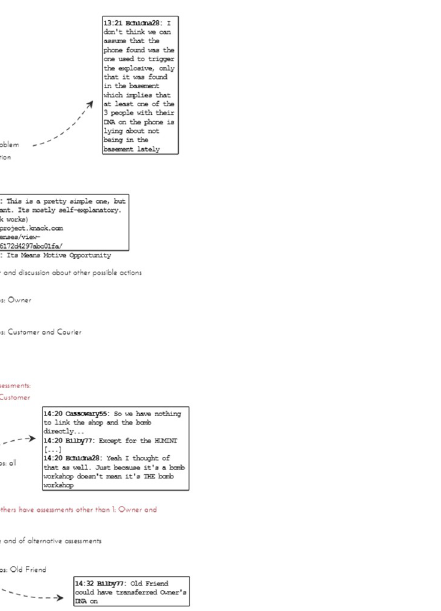
Fig 2. A sample selection of the timeline visualization for team